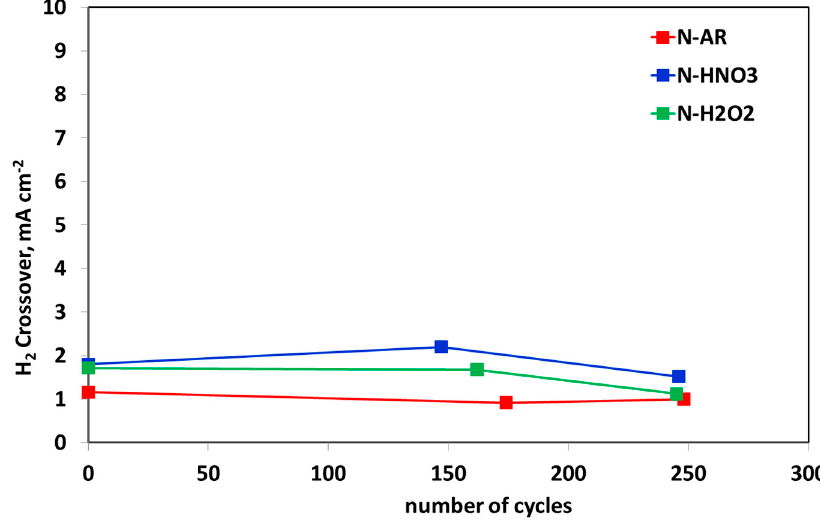
Figure 12. H 2 crossover trend during ASTs for N-AR (red circles), N-HNO3 (blue squares) and N-H2O2 (green triangles) membranes.